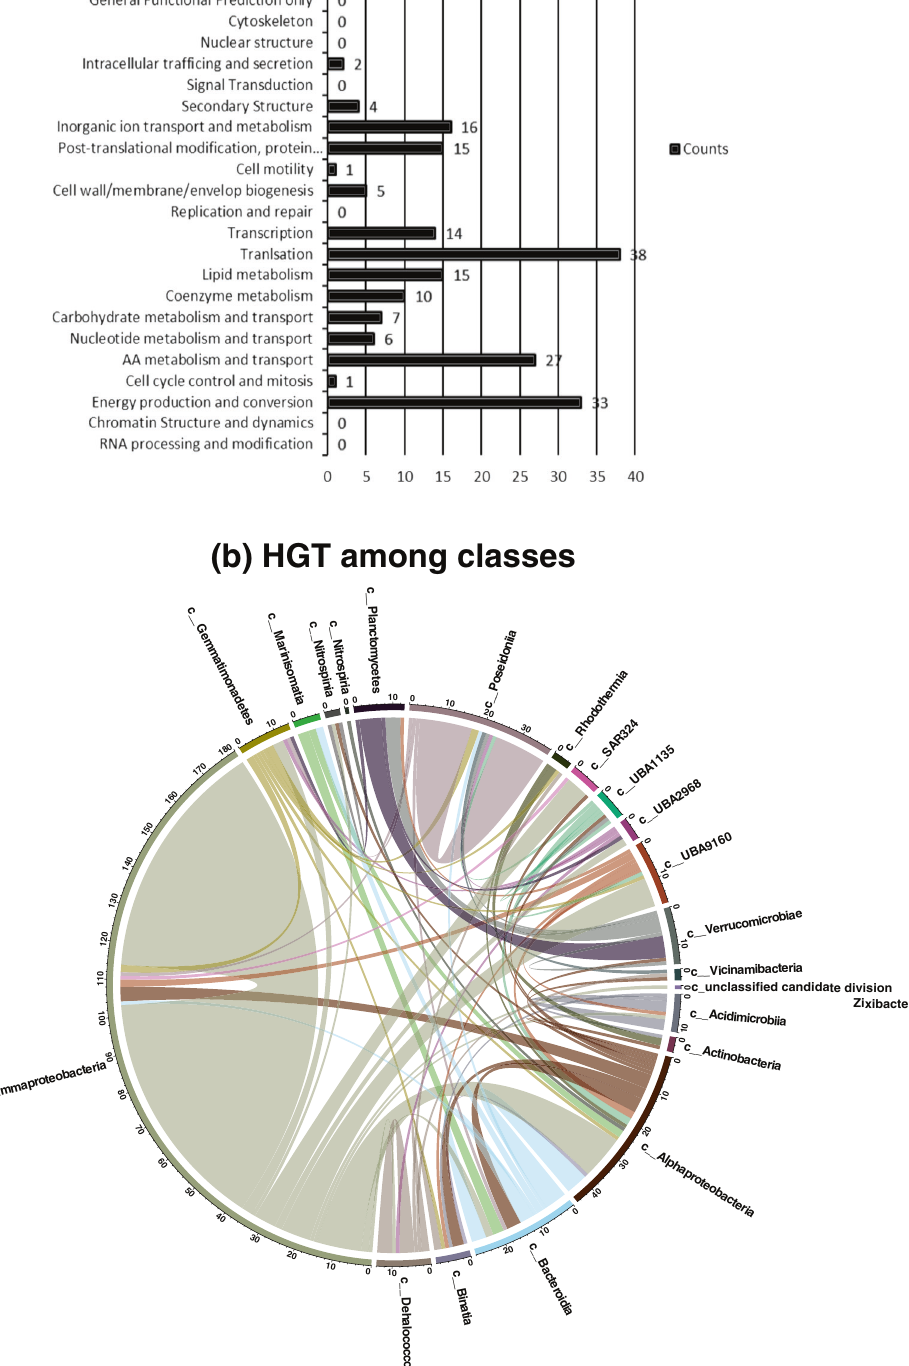
Fig. 8 Horizontal gene transfers (HGTs) in the Guaymas microbiome. a Horizontal gene transfer events annotated to functions. This fi gure represents the number of times a gene responsible for a particular function underwent horizontal transfer. b Horizontal gene transfer among microbial classes. This fi gure traces the microbial classes participating in HGT